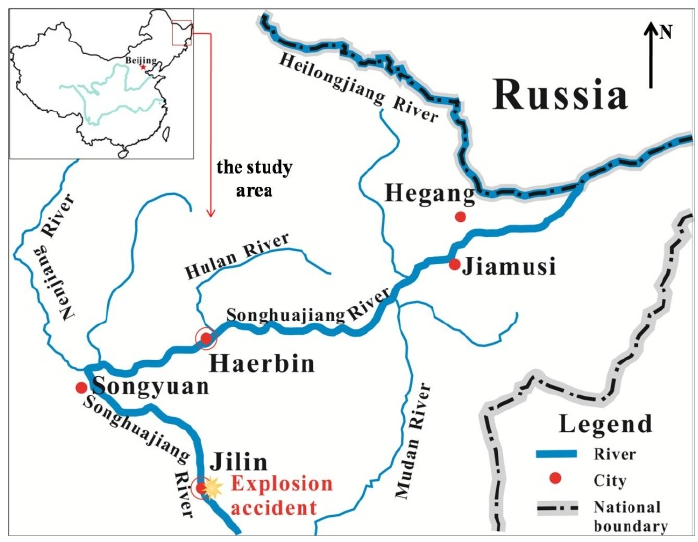
Figure 2. Map of the polluted area in the Songhuajiang River pollution accident.